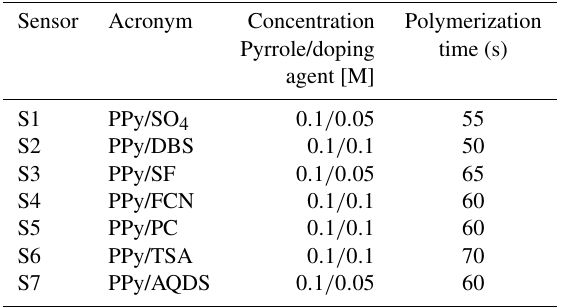
Table 2. Experimental conditions for the electropolymerization of the sensor